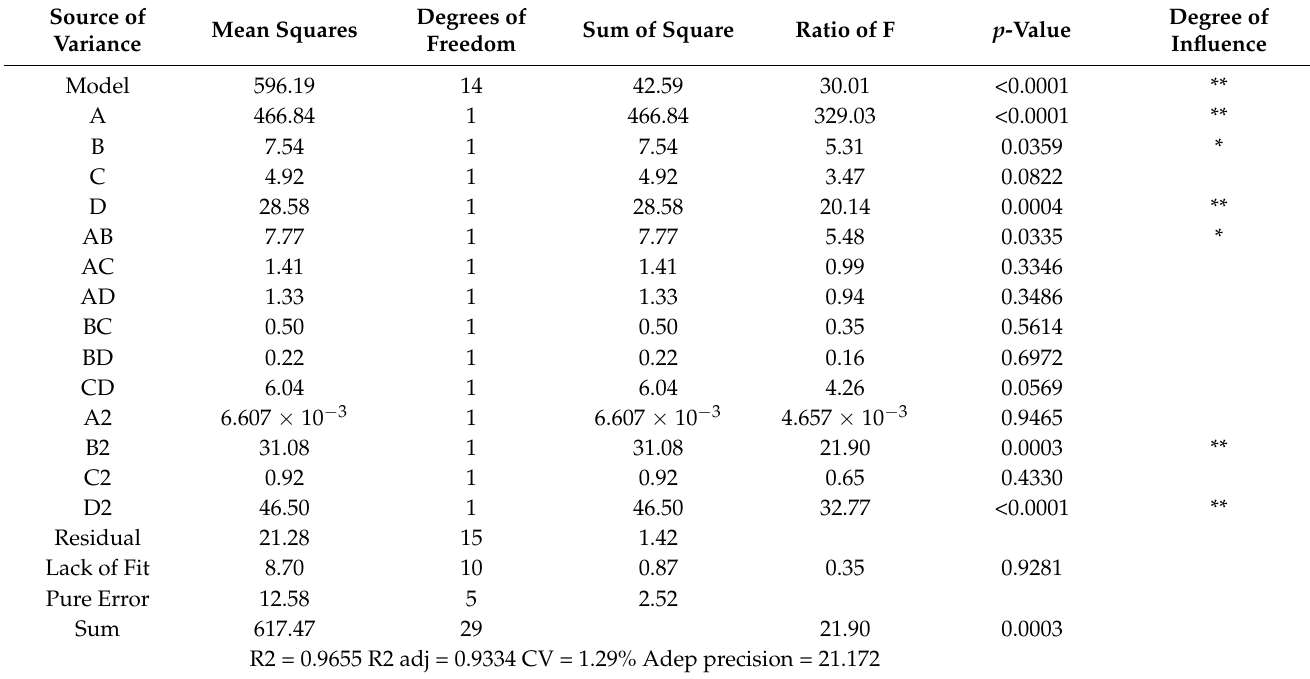
Table 7. Variance analysis of the quadratic regression model for the Central Composite Design response surface